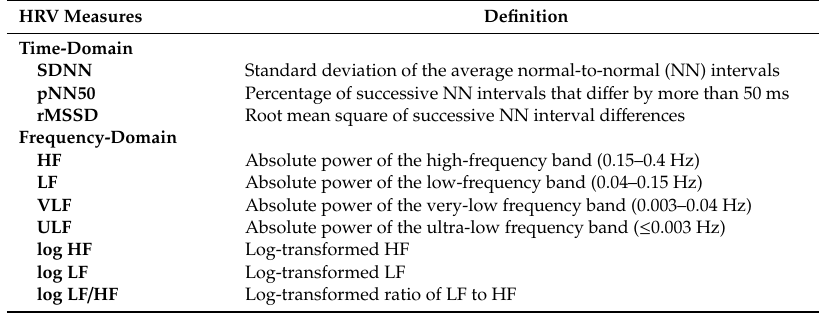
Table 1. Definitions of time-domain and frequency-domain heart rate variability (HRV) measurements.